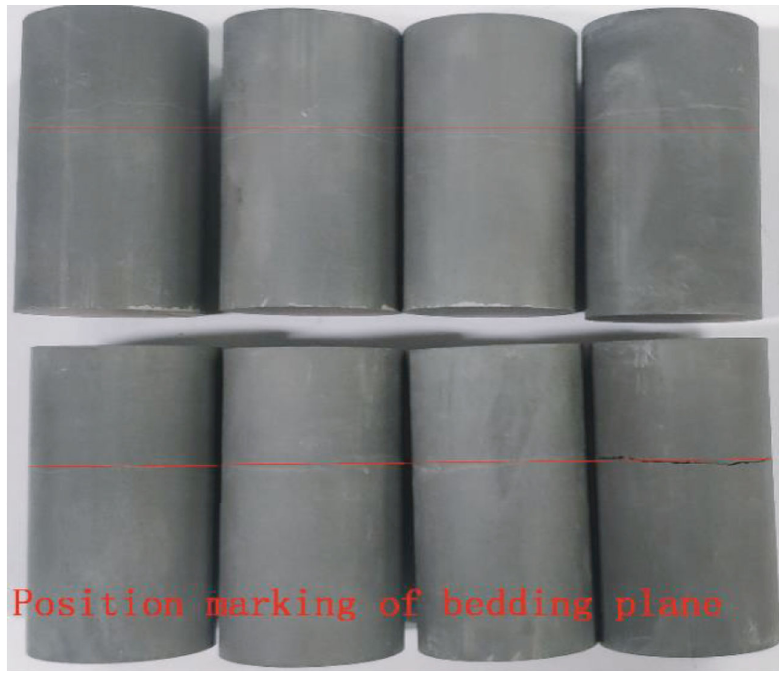
Figure 8: Transition shale samples for mechanical